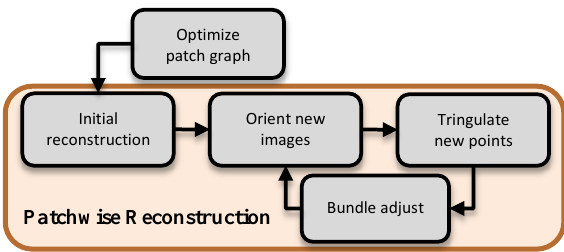
Figure 3. Flowchart for the patchwise reconstruction